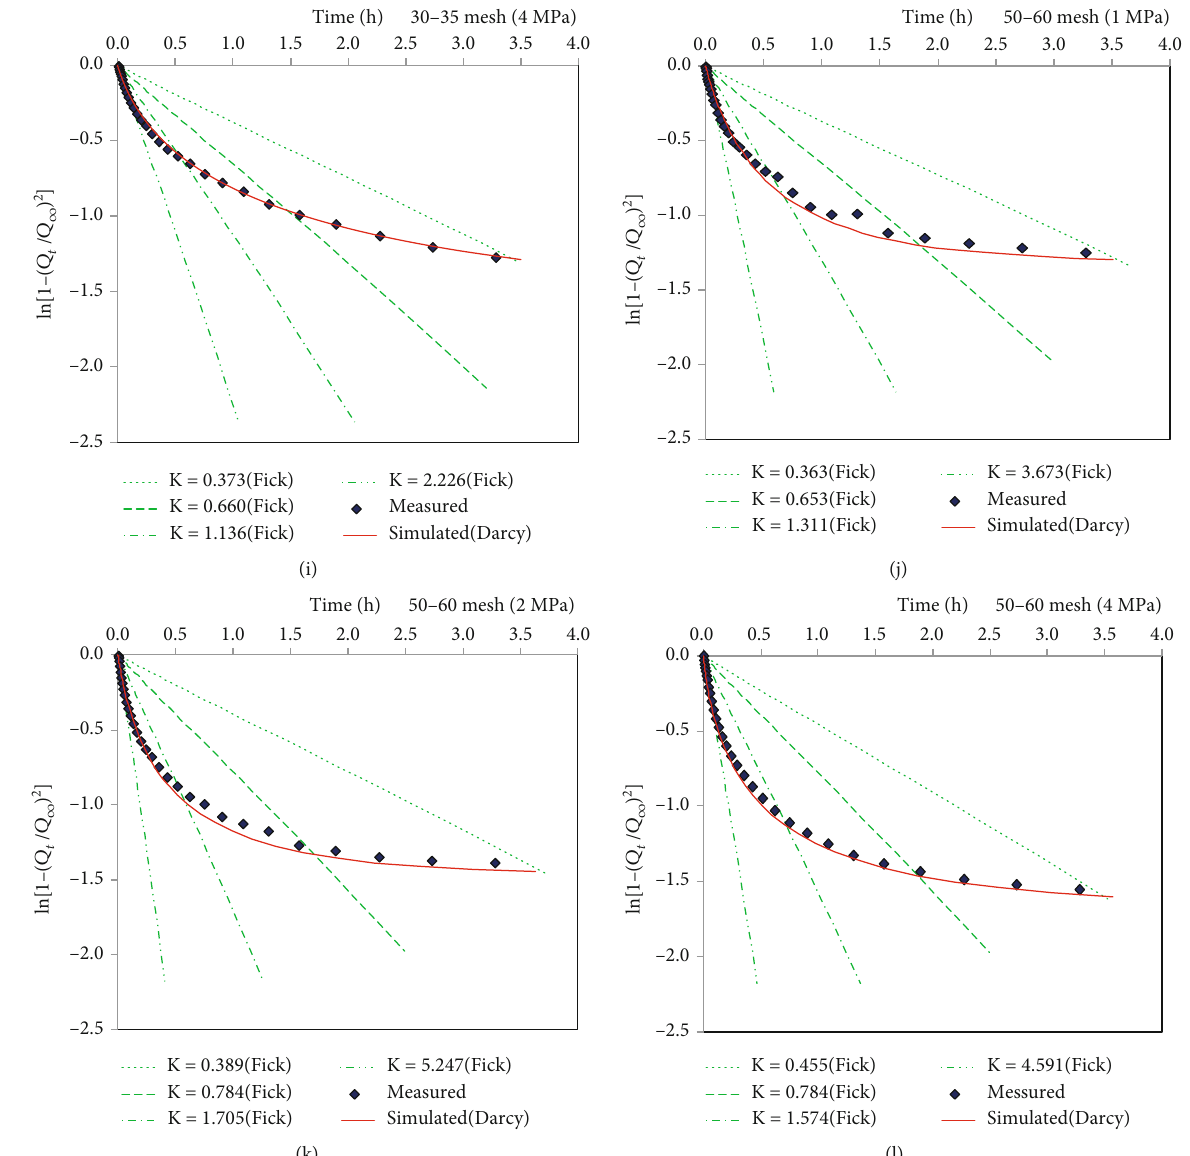
Figure 7: Contrast curves between simulation and experimental